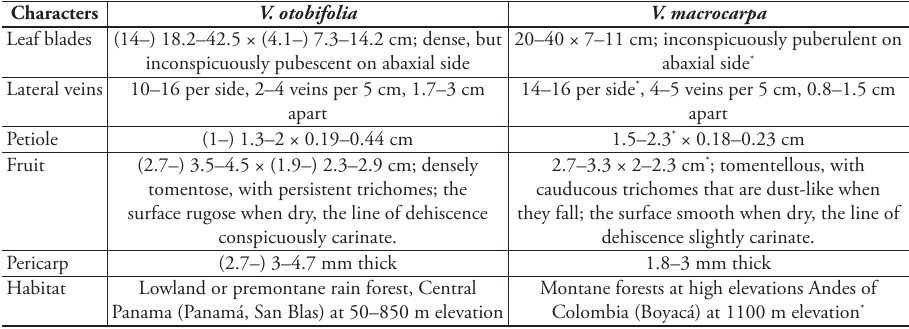
Table 7. Morphological comparison between Virola otobifolia and V. macrocarpa